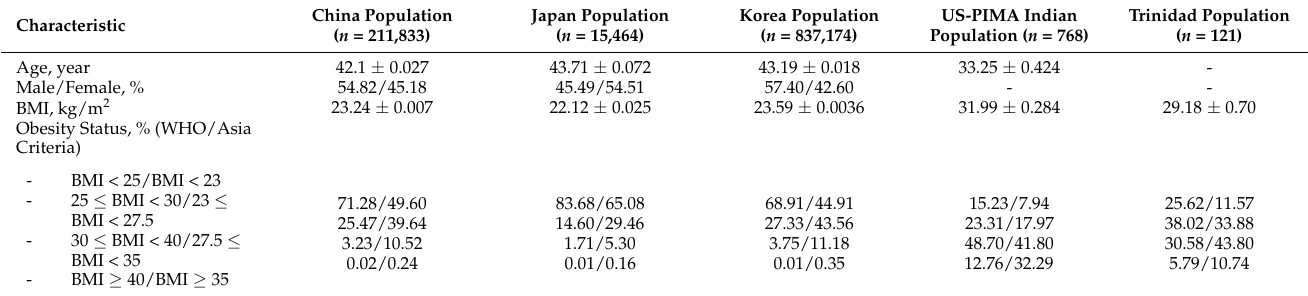
Table 1. Characteristics of the population representing China, Japan, Korea, US-PIMA Indian, and